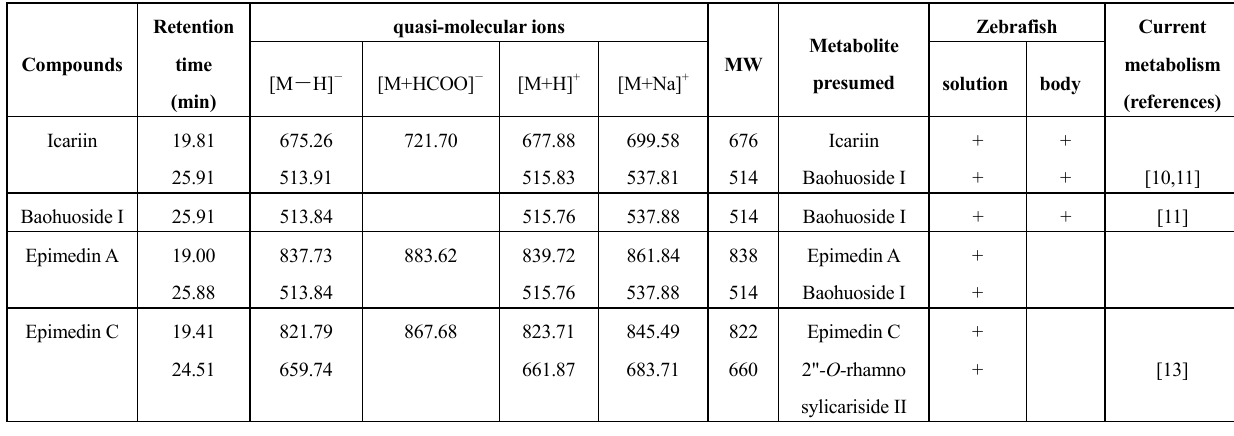
Table 1. MS data for icariin, baohuoside I, epimedin A, epimedin C and their metabolites after zebrafish exposure for 24 h.